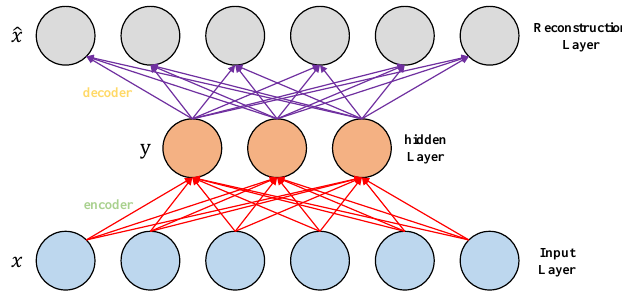
Figure 2. The illustration of the autoencoder network